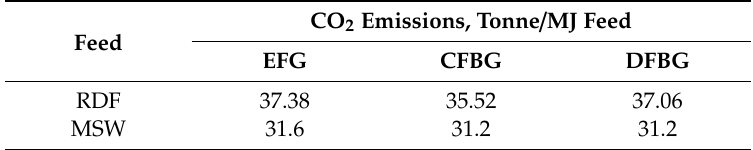
Table 4. CO 2 emissions as t / MJ of feed with di ff erent gasifiers for a 500 MW polygeneration